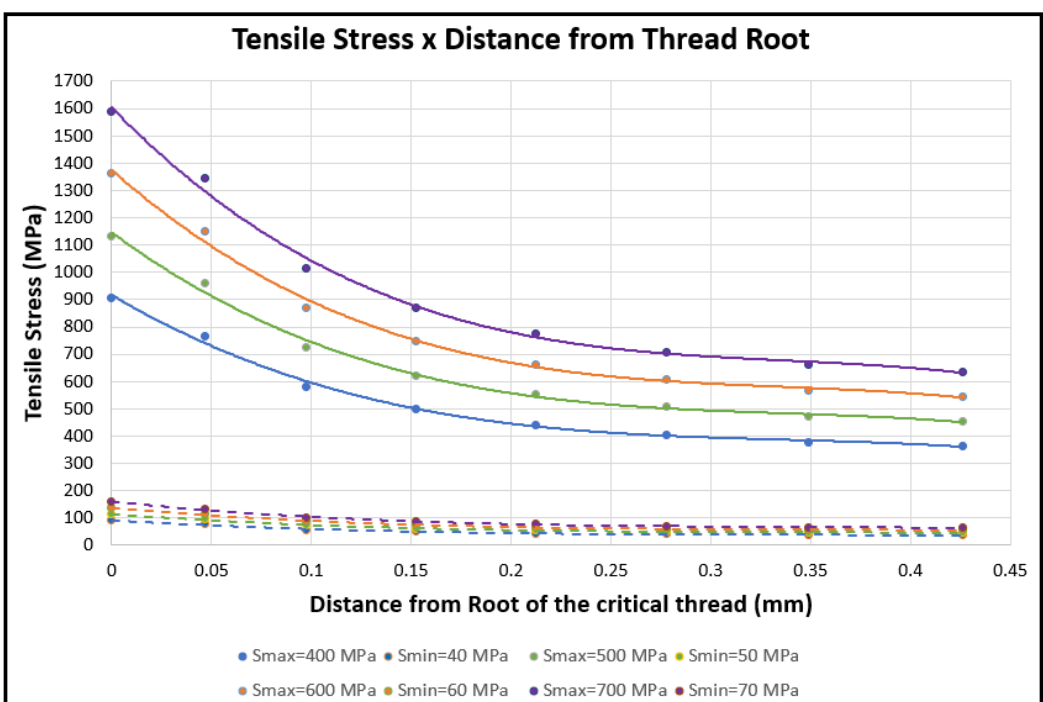
Figure 18. Tensile stress (MPa) from the thread root for thread specimens without the nut interface.